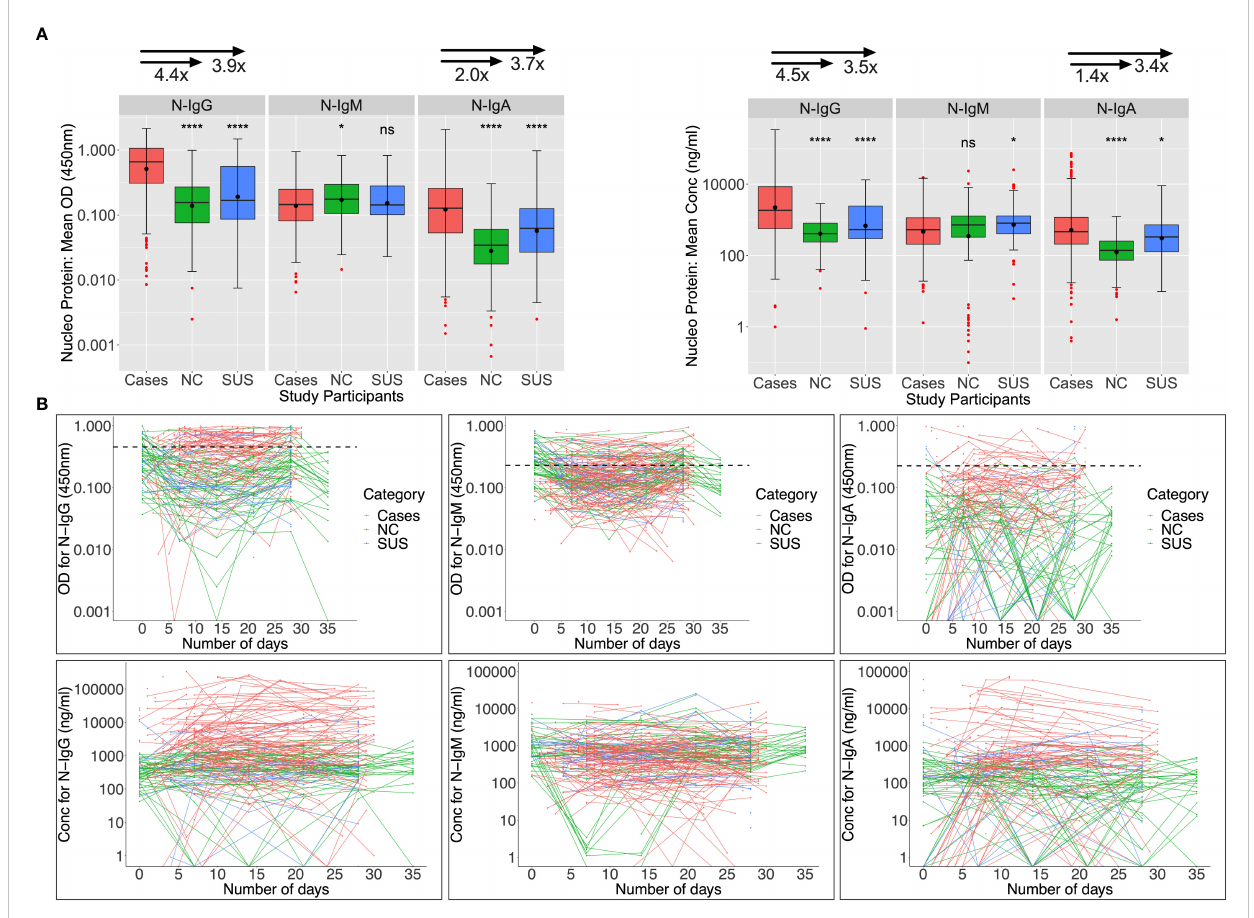
FIGURE 3 Anti-Nucleoprotein antibody responses during the fi rst month of infection. The Nucleoprotein-directed antibodies throughout the fi rst month of infection are summarised in Figure 3. Comparisons are made between PCR-negative, uninfected suspected contacts (SUS), uninfected non-contacts, and SARS-CoV-2 infected patients (NCs). IgG, IgM, and IgA antibody optical densities at 450 nm and concentrations (ng/ml) are compared using box plots and the Kruskal-Wallis test for cases, NC, and SUS participants (A) . Individual anti-spike IgG, IgM, and IgA antibody pro fi les are shown as spaghetti plots in (B) , strati fi ed by exposure to infection and PCR-con fi rmed infection status from the fi rst date of PCR or admission. Signi fi cant P- values are those that are less than or equal to 0.05; otherwise, they are not signi fi cant (ns); ns p > 0.05, ∗ p ≤ 0.05, ∗ ∗ ∗ ∗ p ≤ 0.0001. The respective IgG, IgM, and IgA cut-off values for the nucleoprotein were 0.454, 0.229, and